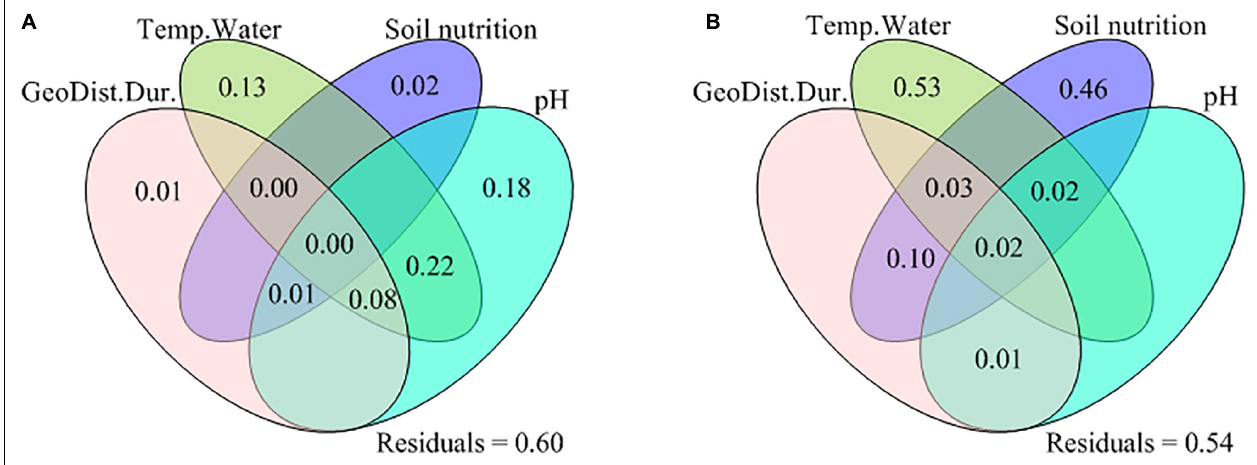
FIGURE 2 | Venn plots of variation partitioning analysis, showing the shared and exclusive effects of the geographic distance and warming duration (GeoDist.Dur.), the Bray-Curtis dissimilarity index of temperature and water availability (Temp.Water: soil temperature, soil moisture, air temperature and/or vapor pressure deficit), the Bray-Curtis dissimilarity index of soil nutrition (ammonium nitrogen, nitrate nitrogen, and/or available phosphorus) and the Bray-Curtis dissimilarity index of pH between C4300 vs. W4500, C4300 vs. W4700, and C4500 vs. W4700, on the (A) species β -diversity and (B) phylogenetic β -diversity between C4300 vs. W4500, C4300 vs. W4700, and C4500 vs. W4700. C4300: the control treatment at site A; C4500: the control treatment at site B; W4500: the warming treatment at site B; W4700: the warming treatment at site